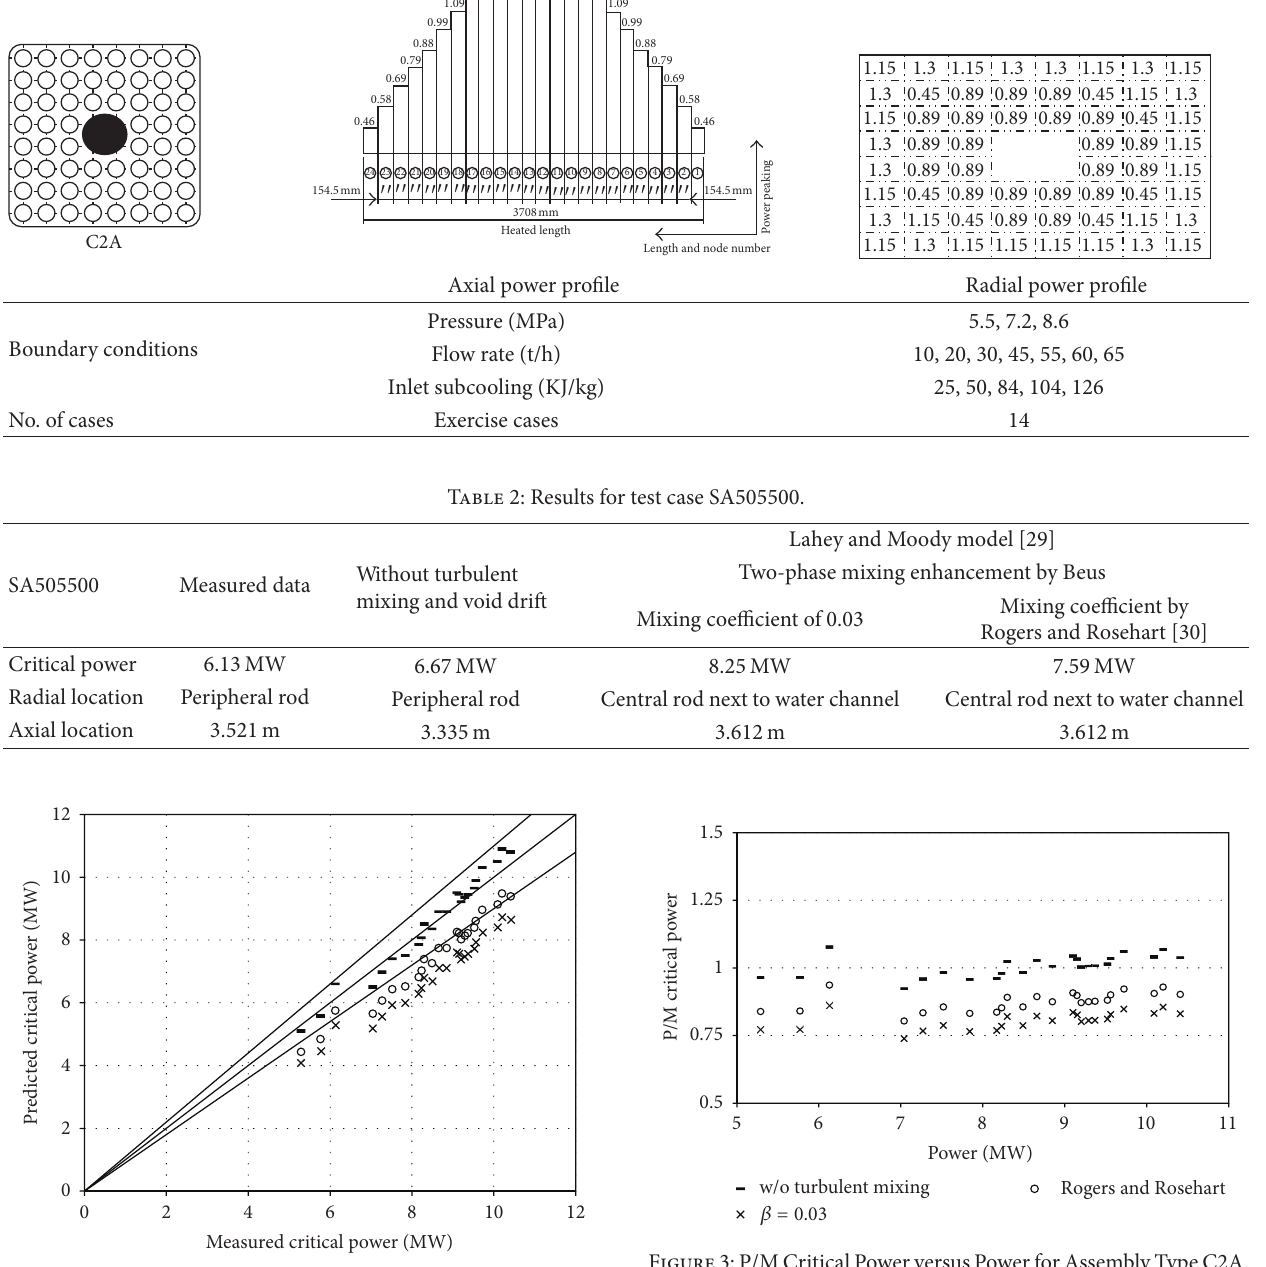
F 3: P/M Critical Power versus Power for Assembly Type C2A.